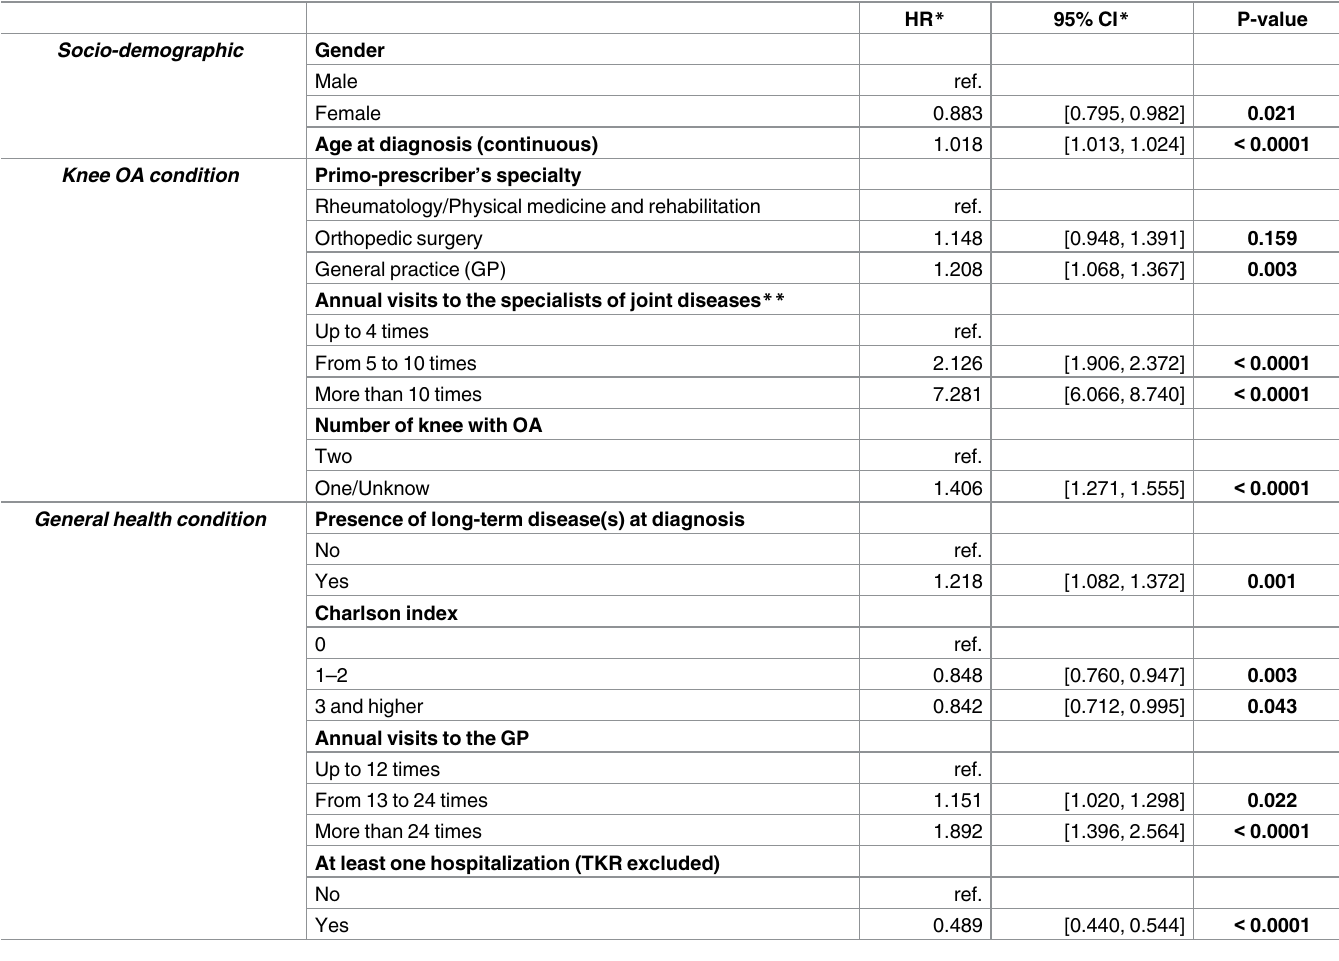
Table 4. Hazard ratios of adjustment covariates from the stratified Cox